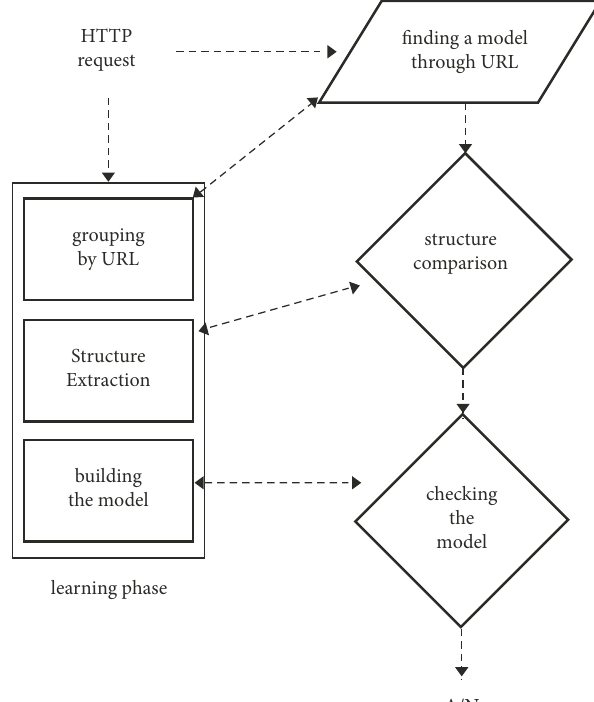
Figure 1: High-level overview of the proposed algorithm.